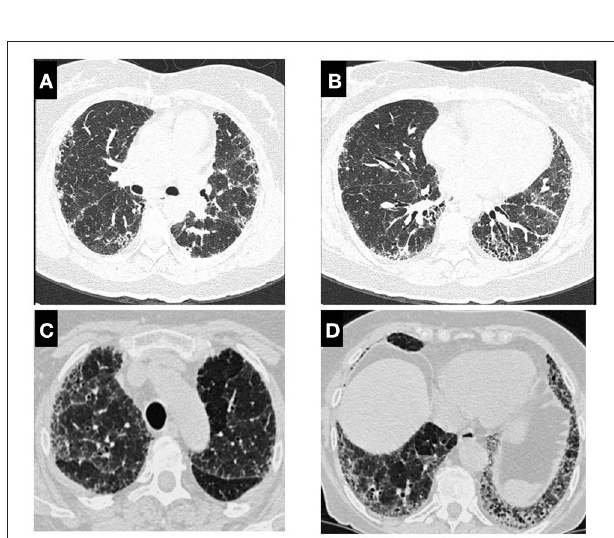
FIGURE 2 | High-resolution computed tomography scan in patients with fibrotic HP. In (A) , it is observed bilateral subpleural reticulation and in (B) traction bronchiectasis, honey combing and discrete ground-glass opacification and volume loss in left lung; (C) show lung fibrosis and areas of low attenuation and the same patient in (D) bronchiectasis and persistence of mosaic attenuation.